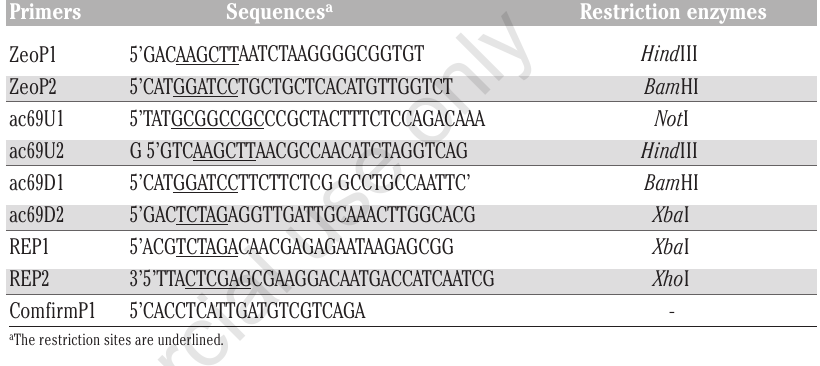
Table 1. Primers used in this